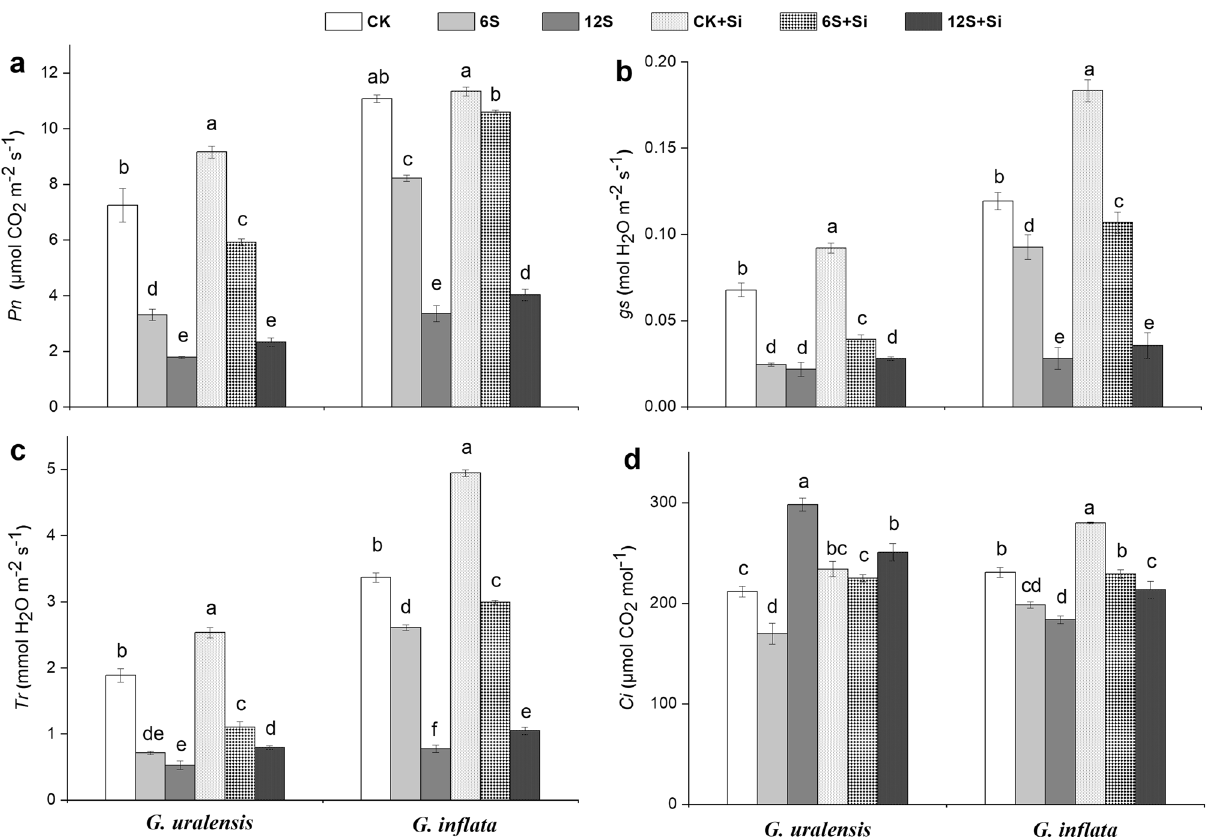
Figure 1. Effects of salinity and Si on net photosynthetic rate ( Pn , a ), stomatal conductance ( gs , b ), transpiration rate ( Tr , c ), and intercellular CO 2 concentration ( Ci , d ) in the two liquorice species. Data are presented as the mean ± SE (n = 3). Different letters indicate significant differences between the values for one index for the same liquorice species under different treatments (P <